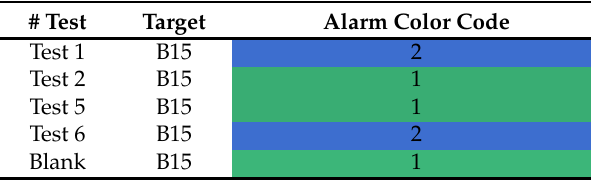
Table 13. Results of the analysis of the spectra pretreated by linear detrend.